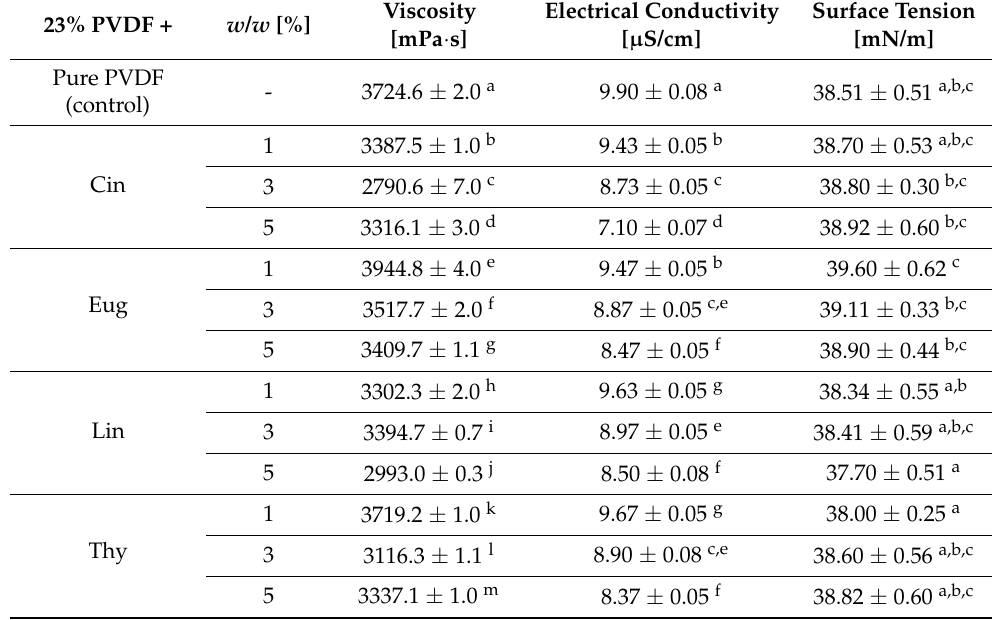
Table 1. Physical characterization of PVDF solutions (viscosity, electrical conductivity and surface